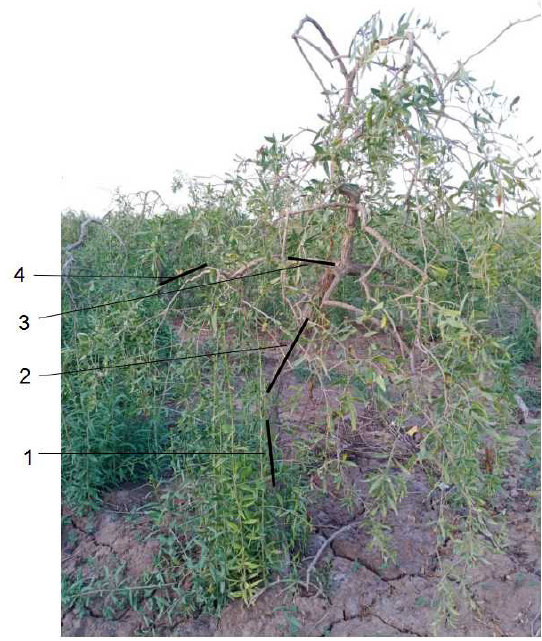
Figure 1. Structure and composition of the Lycium barbarum branches: (1) main branch; (2) primary branches; (3) secondary branches; (4) fruit branches.